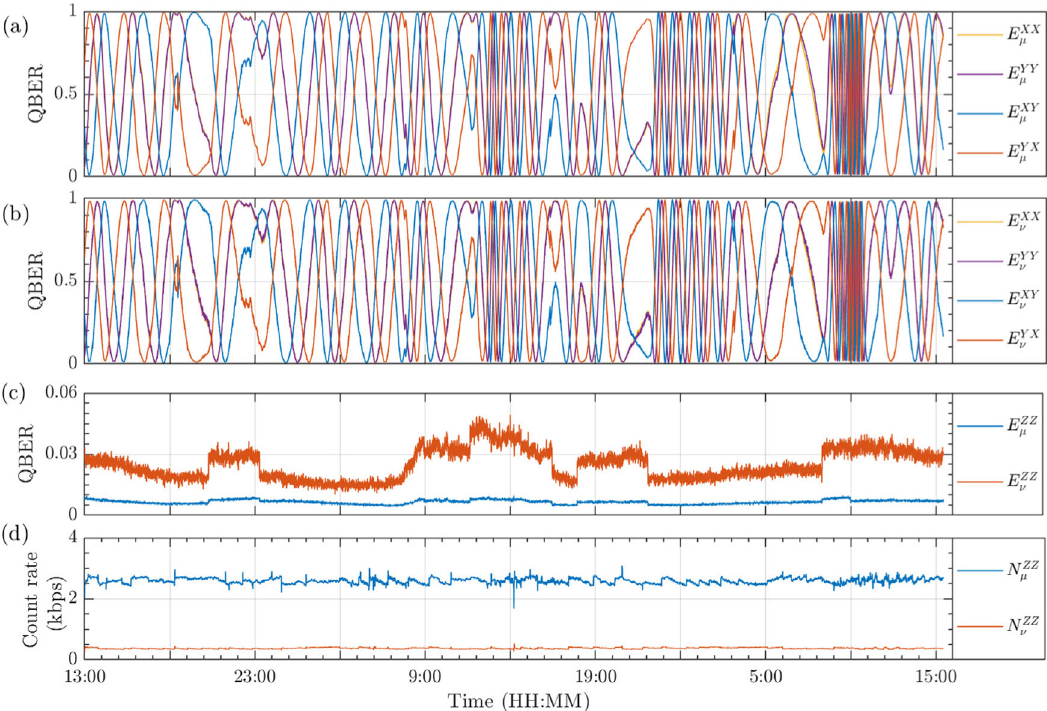
Fig. 2 The measured QBER in each basis, and the count rate in Z basis. Each point is measured within 5 s. a , b shows the QBER of signal (decoy) state on X , Y basis for the total 50.7 h, c shows the QBER of signal state and decoy state on Z basis: E ZZ μ and E ZZ ν , and d shows the count rate of signal and decoy state on Z basis: N ZZ μ and N ZZ ν